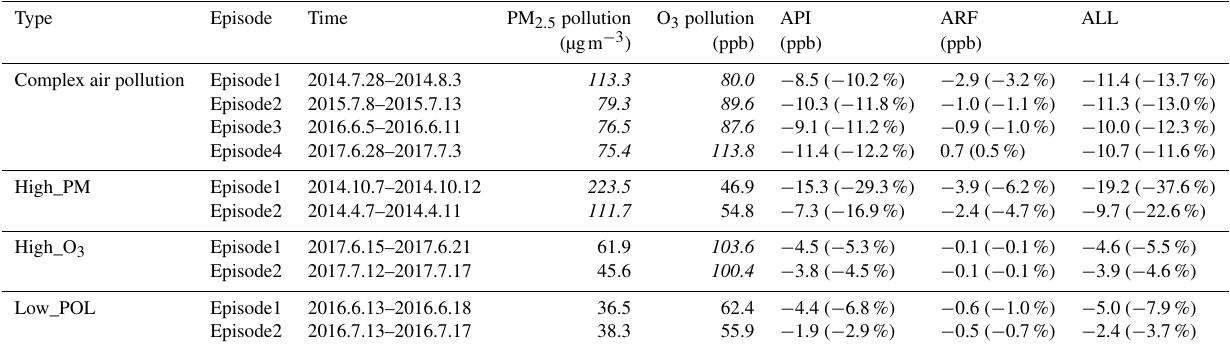
Table 2. Detailed information of the analysed episodes, including the impacts of API, ARF, and ALL on O 3 concentrations under different air pollution conditions. The numbers in italics indicate the concentrations exceeded the Class II limit of the National Ambient Air Quality Standards of China. The numbers in parentheses indicate the percentage changes in the O 3